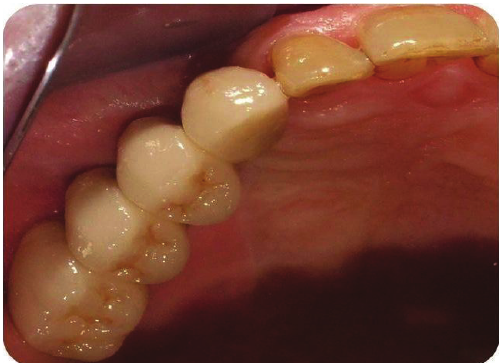
Figure 9: Metal supported porcelain bridge.